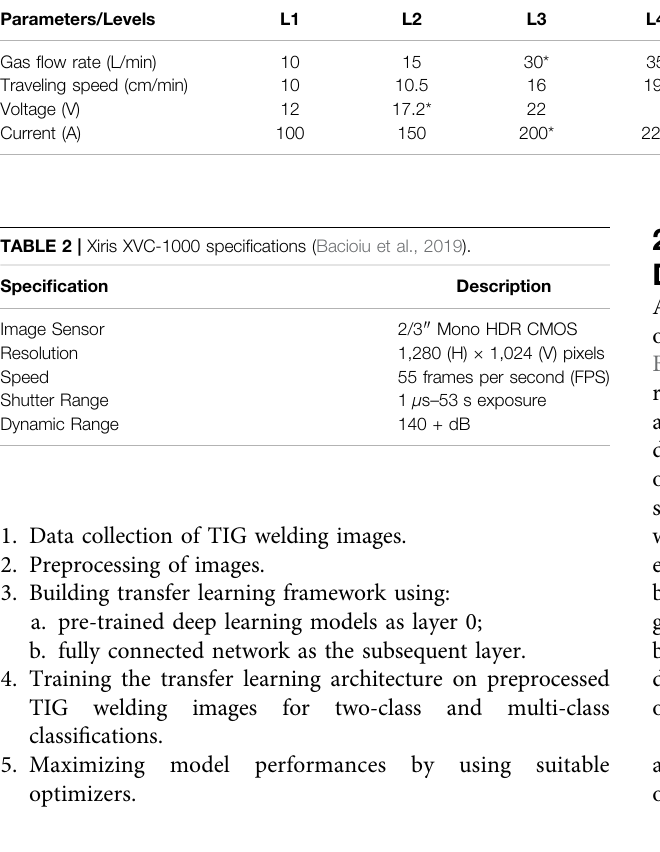
Frontiers in Mechanical Engineering |